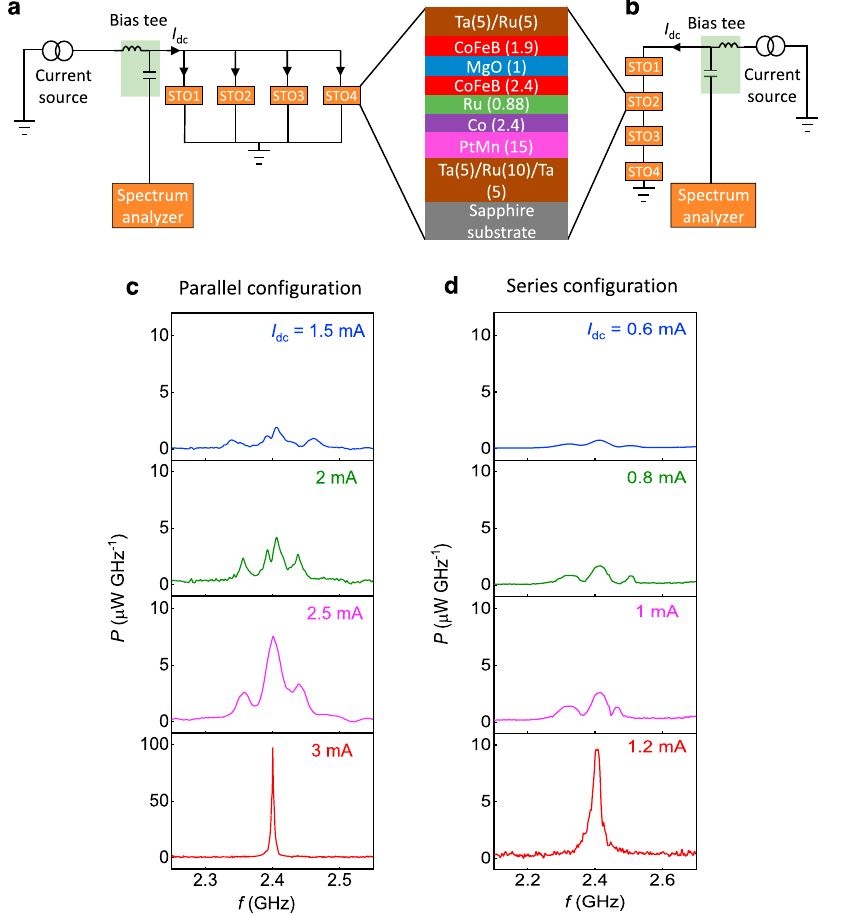
Fig. 1 Spin-torque oscillator synchronization with dc bias. a , b STO measurement set-up using dc bias ( I dc ) and spectrum analyzer for the parallel ( a ) and series ( b ) connection, respectively. I dc is supplied by the current source and the bias tee isolates the dc bias and the microwave output signal from the STOs. The rf output is then fed into the spectrum analyzer. The device stack is also shown with the numbers in brackets representing the individual layer thickness in nm. c , d Power spectral density measured in the spectrum analyzer by increasing the dc bias for the parallel ( c ) and series ( d ) connections, respectively. The magnetic fi eld was adjusted with a different dc bias to obtain the single spectral peak at 2.4 GHz. For the condition of synchronization of four oscillators at 2.4 GHz with I dc,sync = 3 mA (1.2 mA) for the parallel (series) con fi guration, the in-plane magnetic fi eld of 180 Oe (140 Oe) is applied along the major axis of the